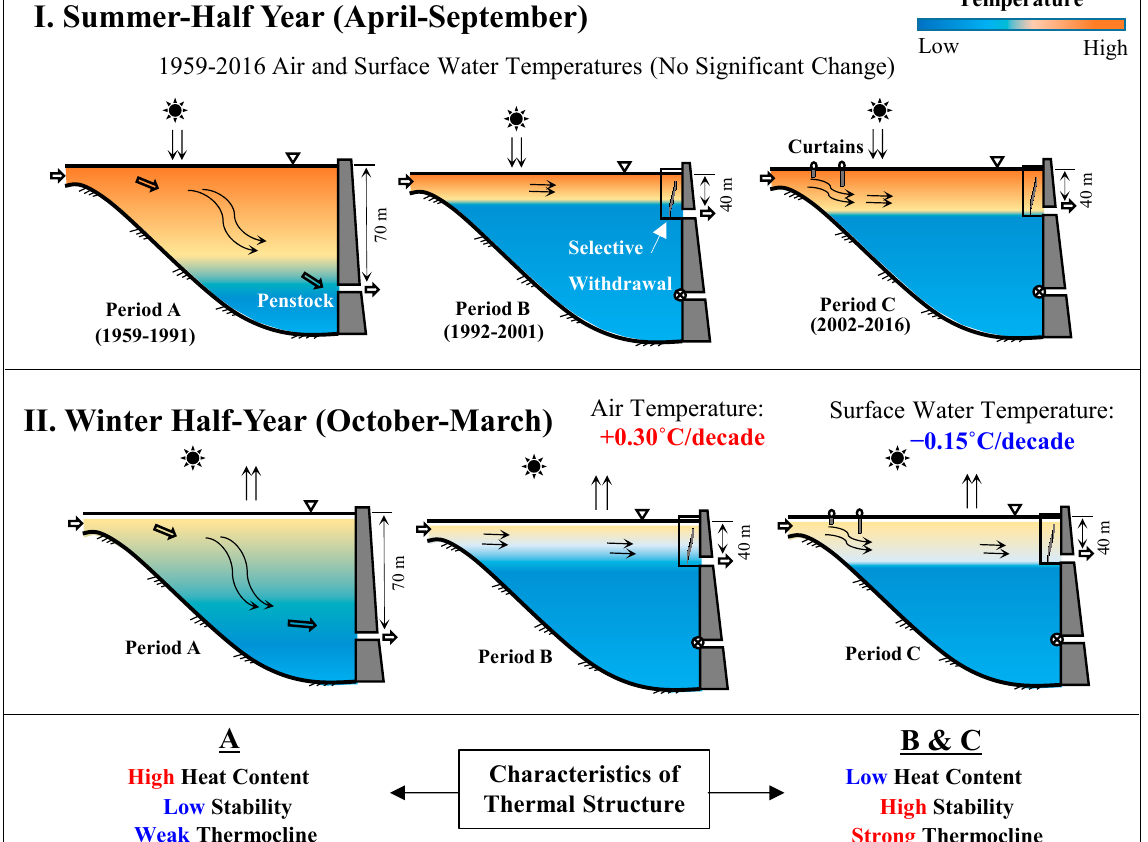
Figure 9. Effect of climate warming and facilities on the reservoir’s thermal structure.